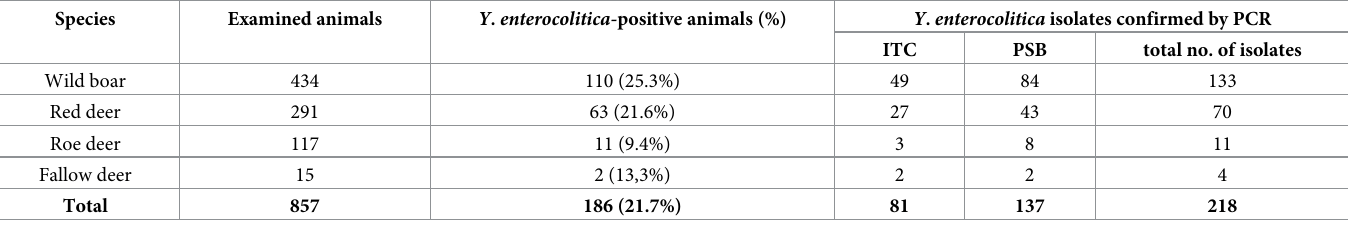
Table 1. Results of the bacteriological study, including the number of Yersinia spp. confirmed by PCR. Species Examined animals Wild boar Red deer 291 Roe deer Fallow deer